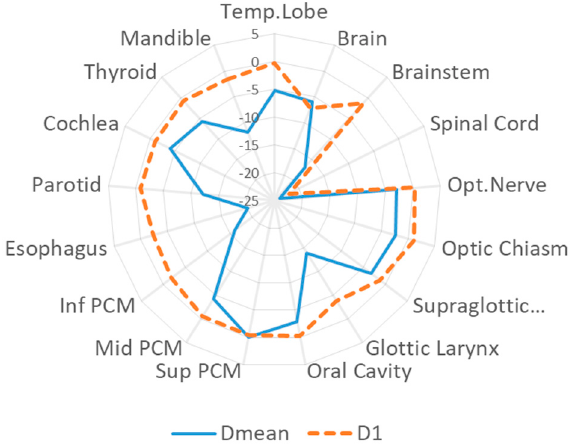
Figure 1. ∆ DMean, ∆ D1 [Gy(RBE)] between IMPT and VMAT plans for the analyzed OARs.